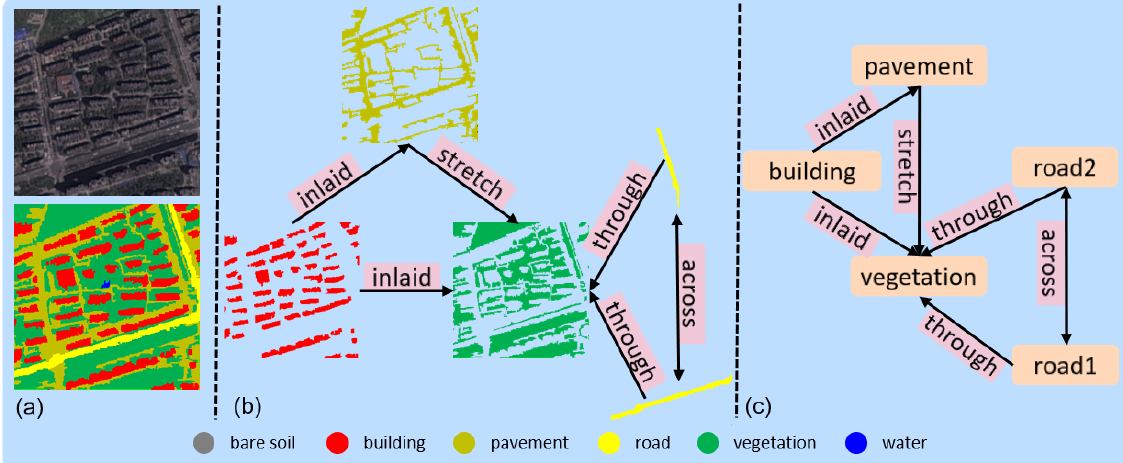
Figure 1. The illustration of a scene graph for a remote sensing image. ( a ) The visible light remote sensing image and the corresponding segmentation result are used as the input of the RSSGG_CS model. ( b , c ) are the scene graph of the image in ( a ). The words on the edges indicate the semantic relationships between objects, and the nodes of the scene graph are represented by the pixel-level segmentation and the category nouns of the instances,